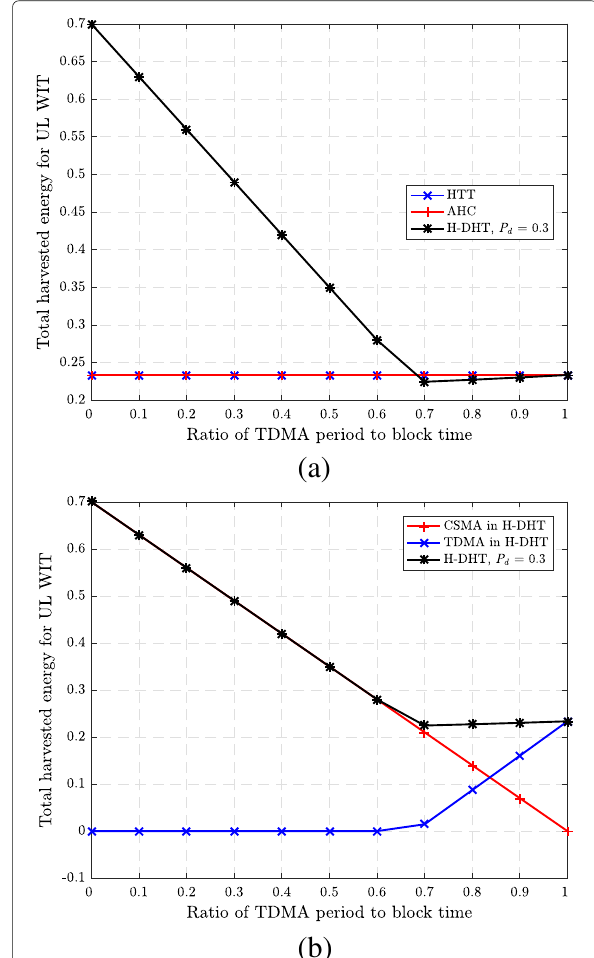
Fig. 6 Total harvested energy according to the ratio of TDMA period to block time. a shows the total harvested energy for UL WIT according to the ratio of TDMA period to block time. We can see that the total harvested energy decreases according to the increase of the ratio of TDMA period to a block time. In addition, b shows that the harvested energy during CSMA period decreases according to